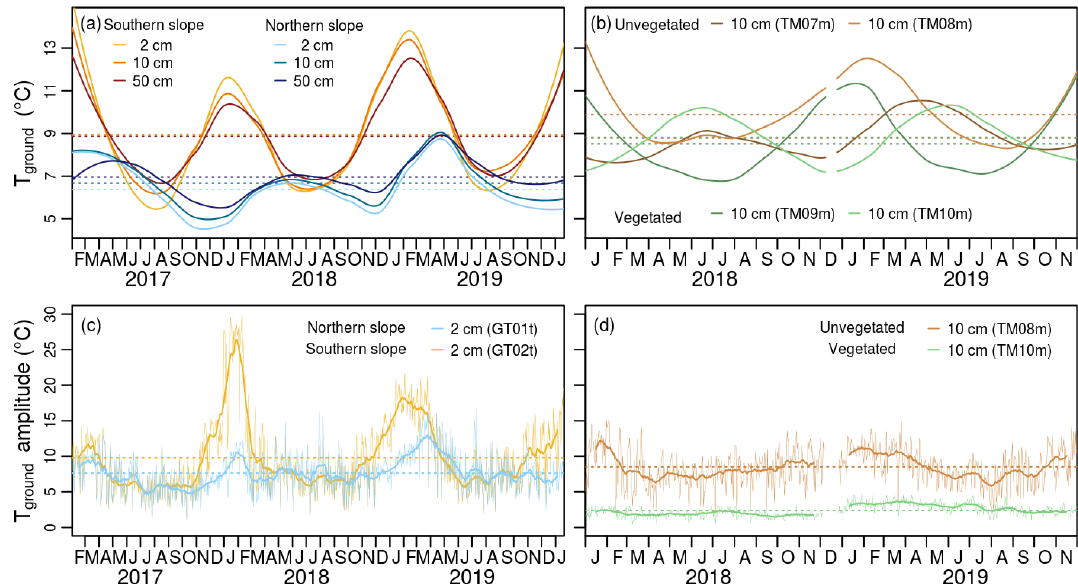
Figure 8. (a) Comparison between smoothed hourly ground temperatures at 2, 10, and 50cm depth on the northern slope (elevation: 4181m; data loggers: GT01t, GT01m, and GT01b) and on the southern slope (4153m; GT02t, GT02m, and GT02b) of Mount Wasama. (b) Compar- ison between smoothed ground temperatures at 10cm depth at sites with an Erica cover and sites without. Note that the data loggers TM07m and TM10m are located on west-exposed slopes, while TM08m and TM09m are located on south-exposed slopes. A local regression with a smoothing span of 0.32 was applied to derive long-term ground temperature variations from hourly measurements. The colour-coded dashed lines indicate the mean of each time series. (c) Daily ground temperature amplitude of data loggers GT01t and GT02t and (d) data loggers TM08m and TM10m. The bold lines represent smoothed daily values using a simple moving average with a window size of 31d.